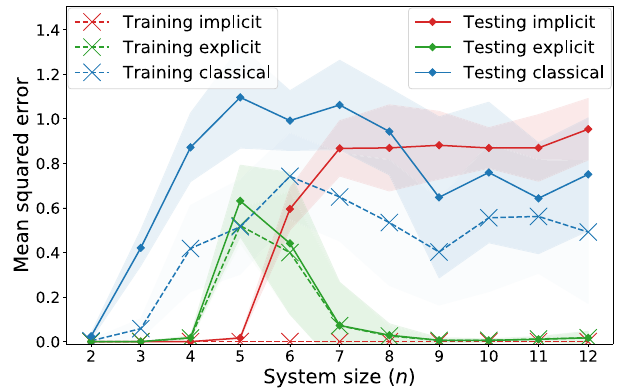
Fig. 6 | Regression performance of explicit, implicit and classical models on a “ quantum-tailored ” learningtask. Forallsystemsizes,eachmodelhasaccesstoa training set of M =1000 pre-processed and re-labeled fashion-MNIST images. Testing loss is computed on a test set of size 100. Shaded regions indicate the standard deviation over 10 labeling functions. The training errors of implicit models are close to 0 for all system